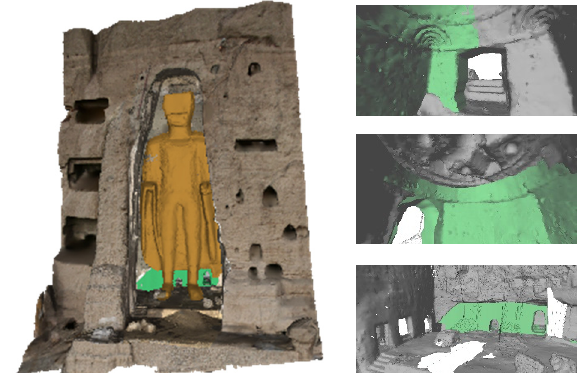
Figure 7. (left): Digital reconstruction of the 38m Buddha in yellow color - (right): series of illustrations on the reconstructed cave complex in green color superposed on the digital model of the niche